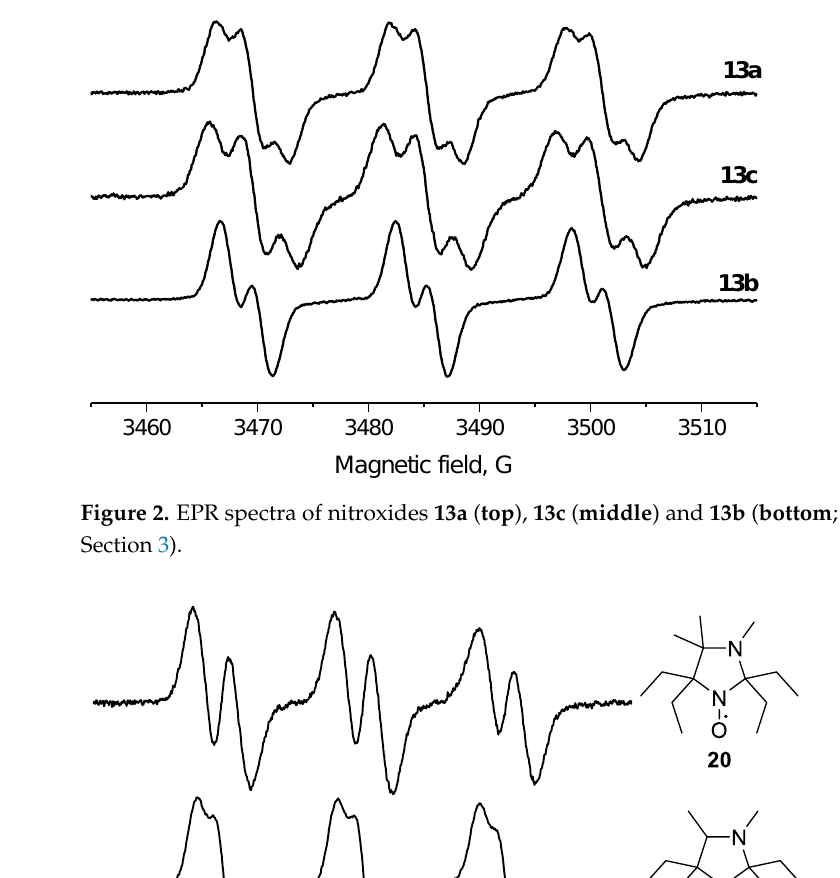
Figure 2. EPR spectra of nitroxides 13a ( top ), 13c ( middle ) and 13b ( bottom ; for conditions, see the Section 3).